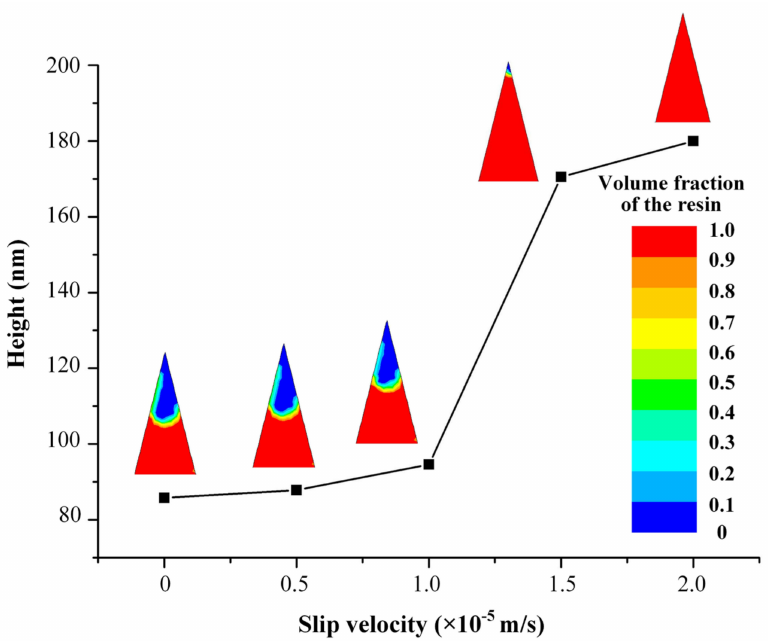
Figure 13. The effect of slip velocity on the filling height of the moth-eye